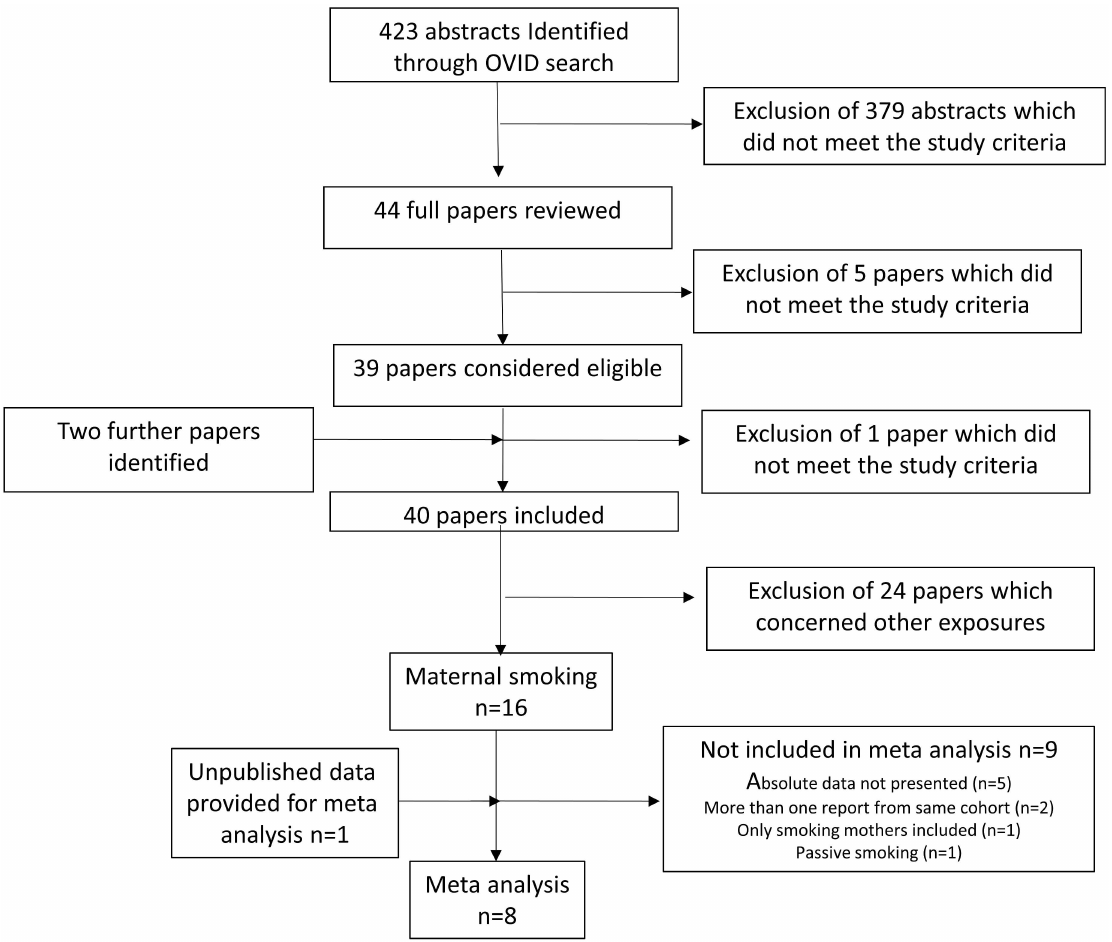
Fig 1. Flow style diagram showing how the papers included in the review were